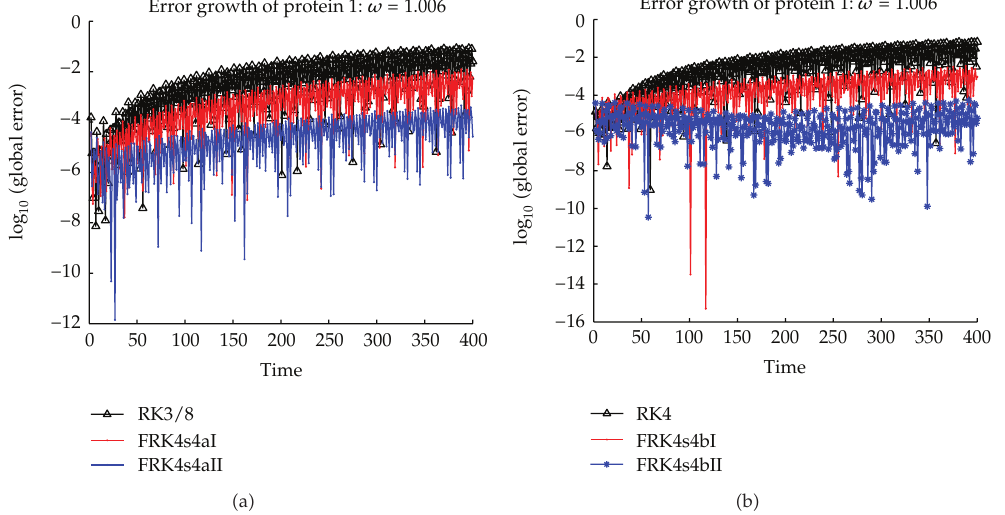
Figure 3: Comparison of (cid:3) a (cid:4) RK3/8, FRK4s4aI and FRK4s4aII (cid:3) left (cid:4) , (cid:3) b (cid:4) RK4, FRK4s4bI and FRK4s4bII (cid:3) right (cid:4)